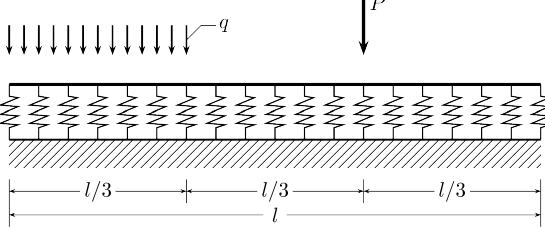
Figure 8. Beam on elastic foundation, problem definition.